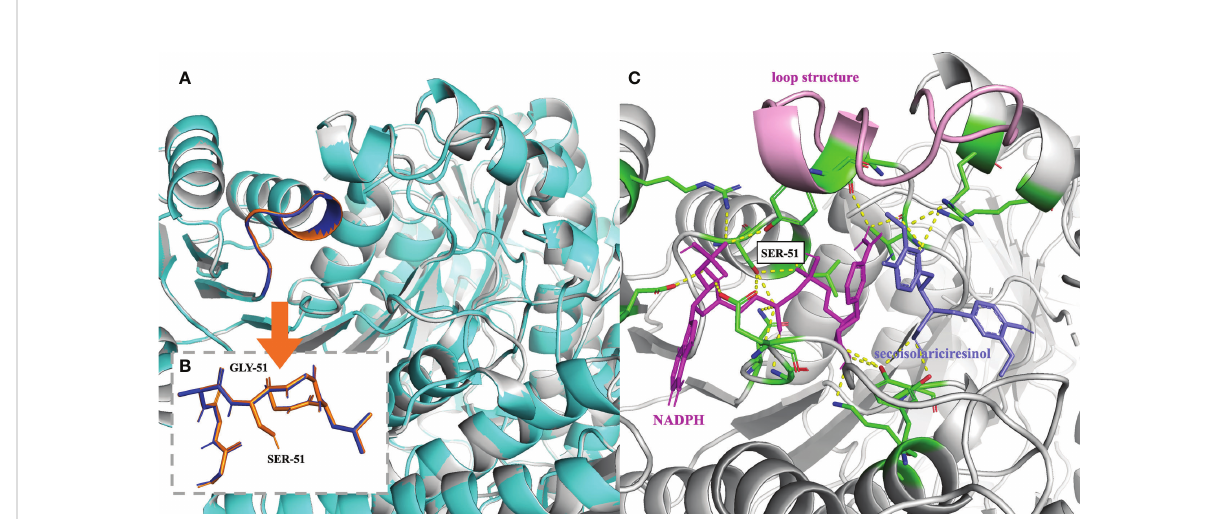
FIGURE 4 Mechanism underlying the cofactor speci fi city of Ii SIRD2. (A) Superimposition of Ii SIRD2 (gray) and Ii SIRD-S51G (cyan). The glycine-rich motif is highlighted ( Ii SIRD-S51G: blue; Ii SIRD: orange). (B) Superimposition of the glycine-rich motif of Ii SIRD-S51G (blue) and Ii SIRD2 (orange). Steric hindrance caused by Ser 51 may alter the way NAD(P) + binds the motif. (C) Structure of Ii SIRD (gray) bound with NADPH (magenta) and secoisolariciresinol (slate). Yellow-dotted lines represent potential hydrogen bonds, and key residues including Ser 51 are marked in green. The loop structure at the pocket entry is marked in